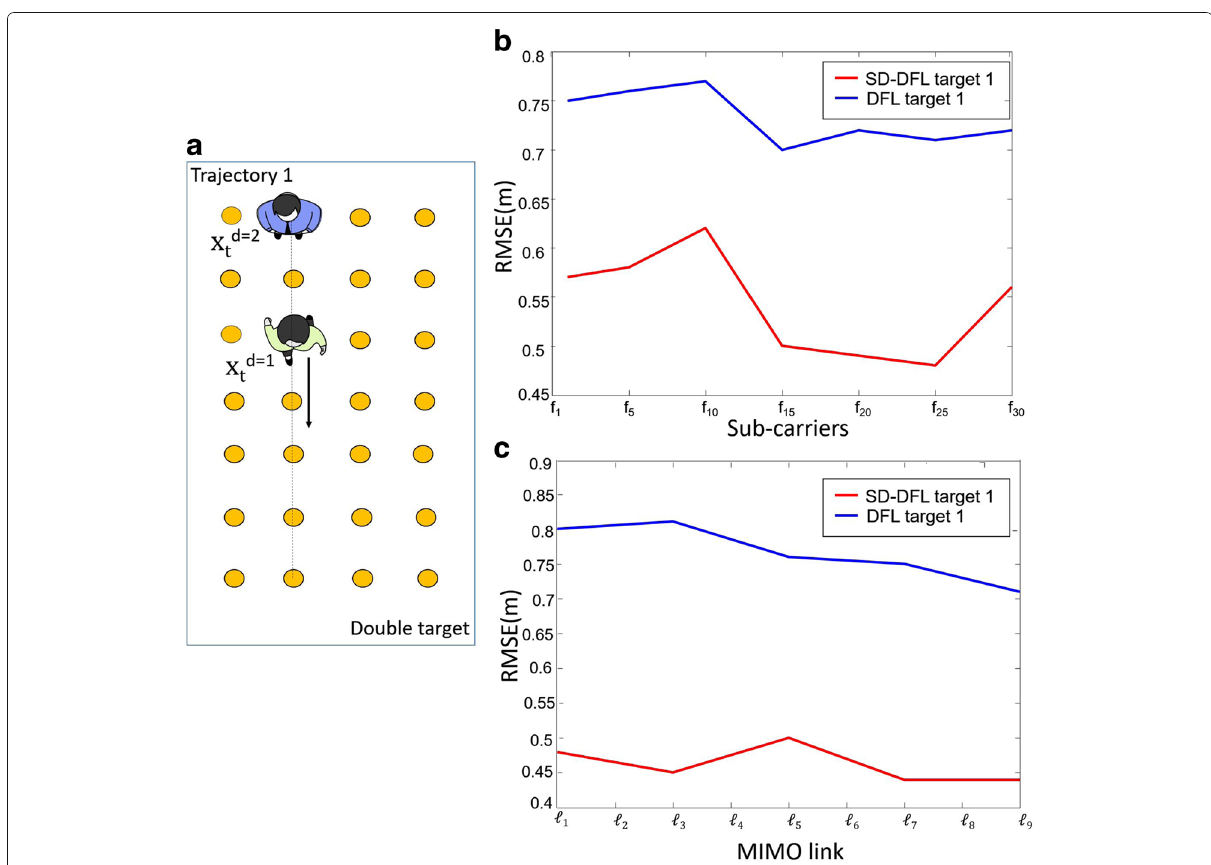
Fig. 9 Double target scenario. a Target d = 2 is standing and target d = 1 is localized while moving on the highlighted trajectory #1. b Positioning RMSE for target d = 1 vs. sub-carriers using space-domain CSI profiles for Bayesian DFL and SD-DFL methods. c Positioning RMSE for target d = 1 vs. MIMO links now using frequency-domain CSI profiles for Bayesian DFL and SD-DFL